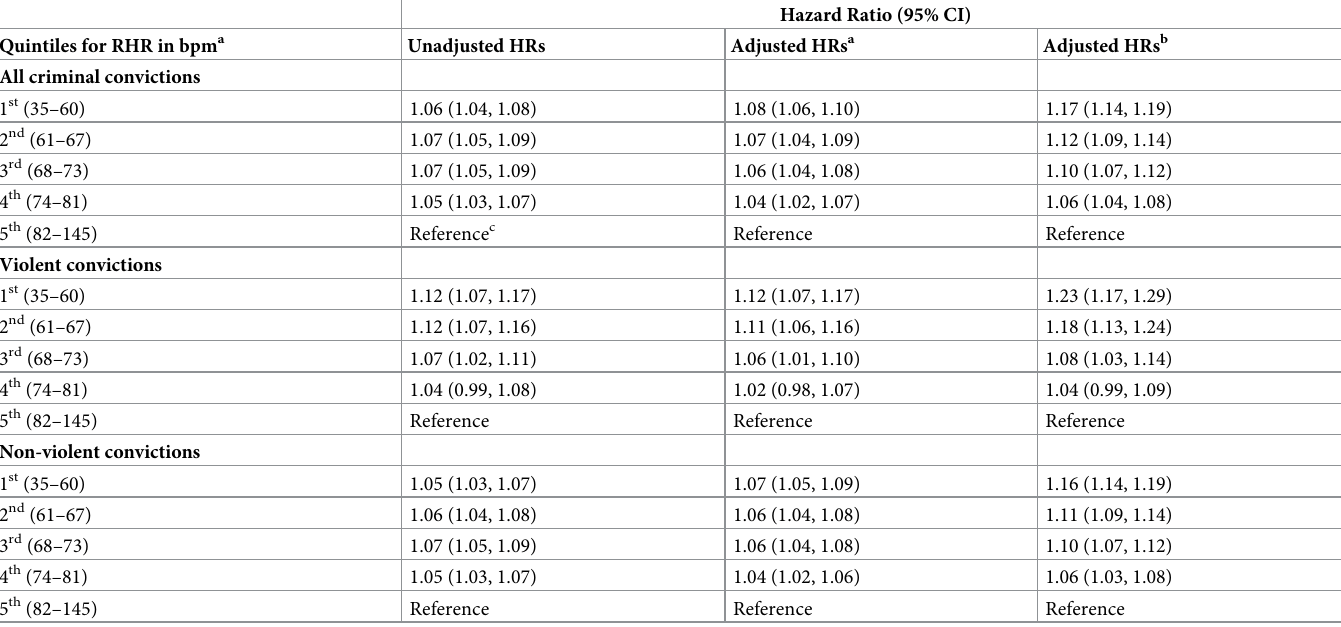
Table 2. Cox proportional hazard regression models for resting heart rate with